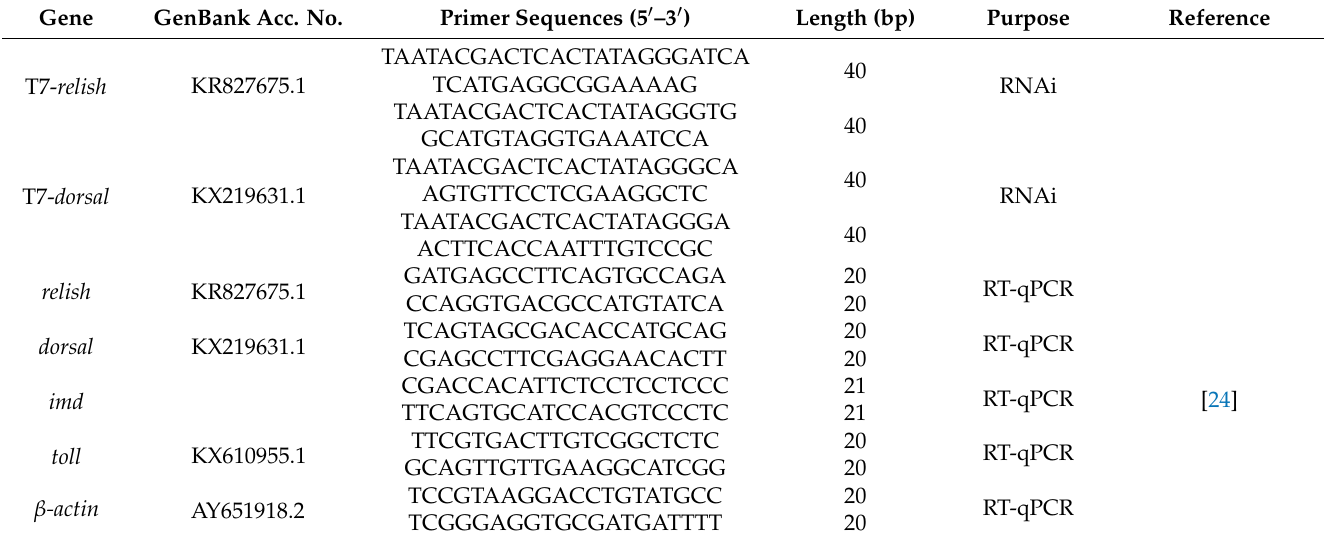
Table 2. Sequences of the primers used in the